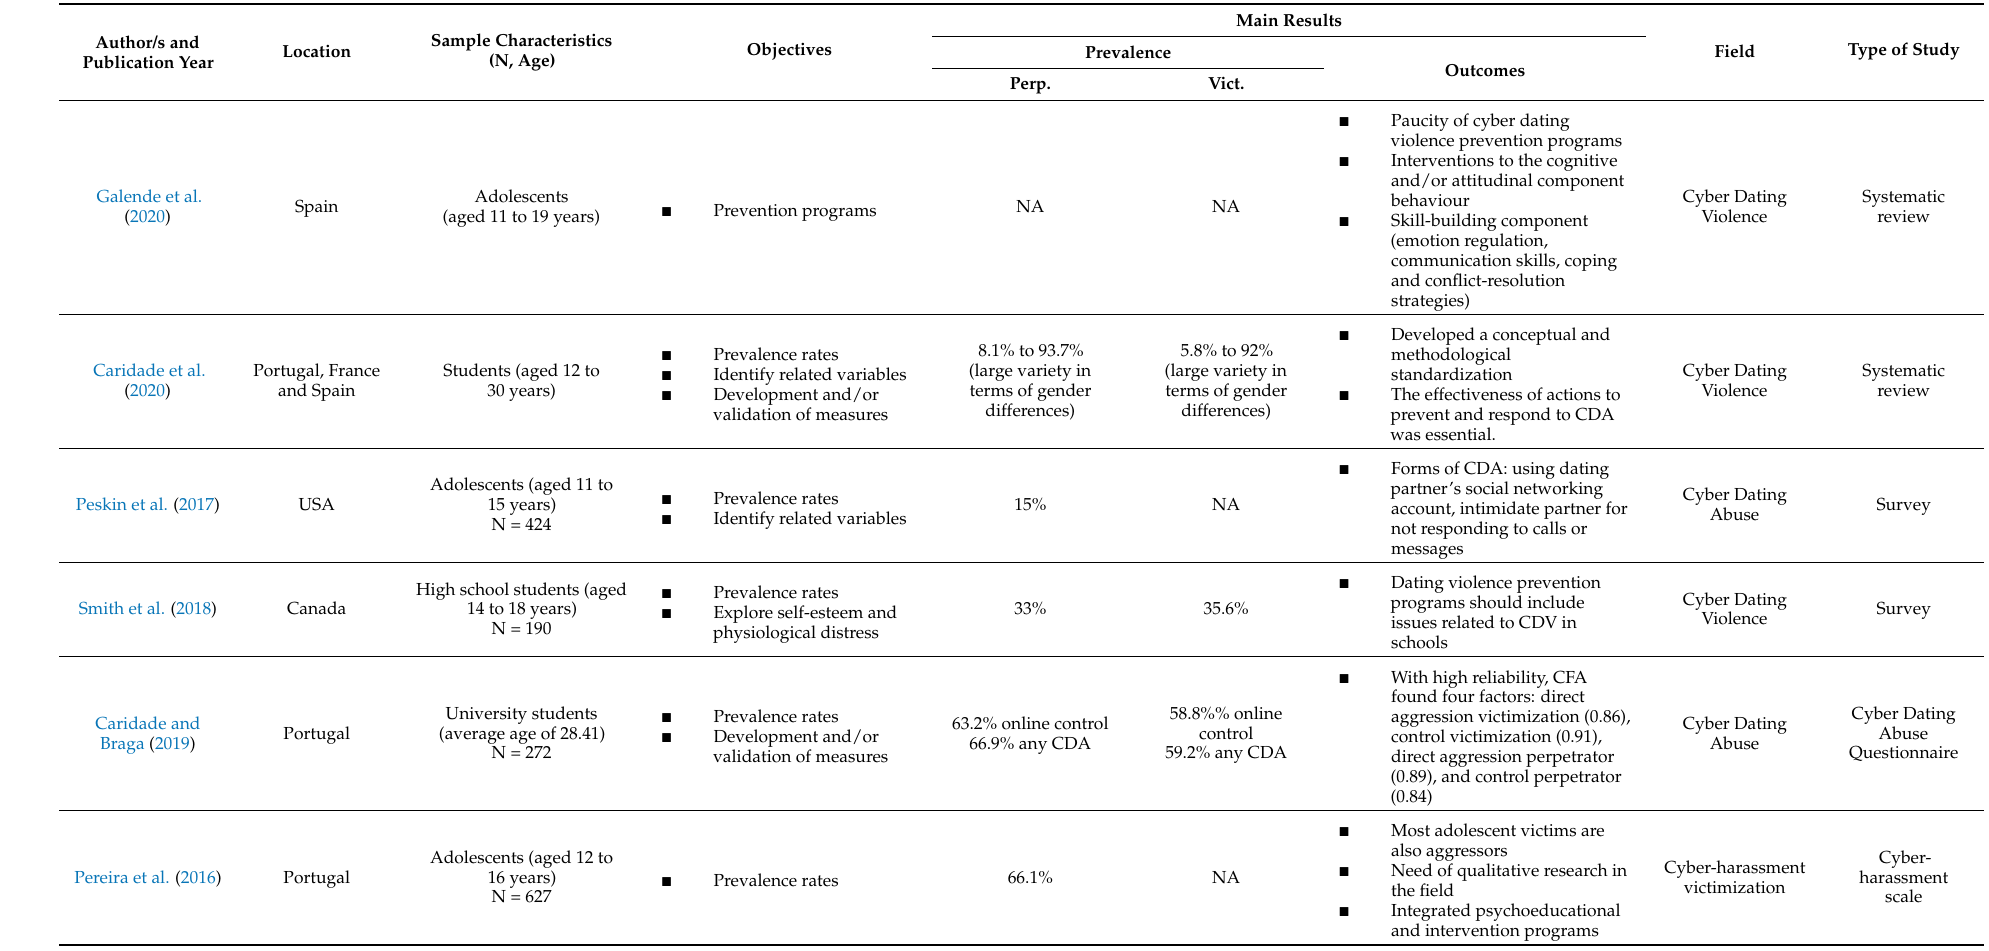
Table 1. Description of studies (n = 18) included in the scoping review